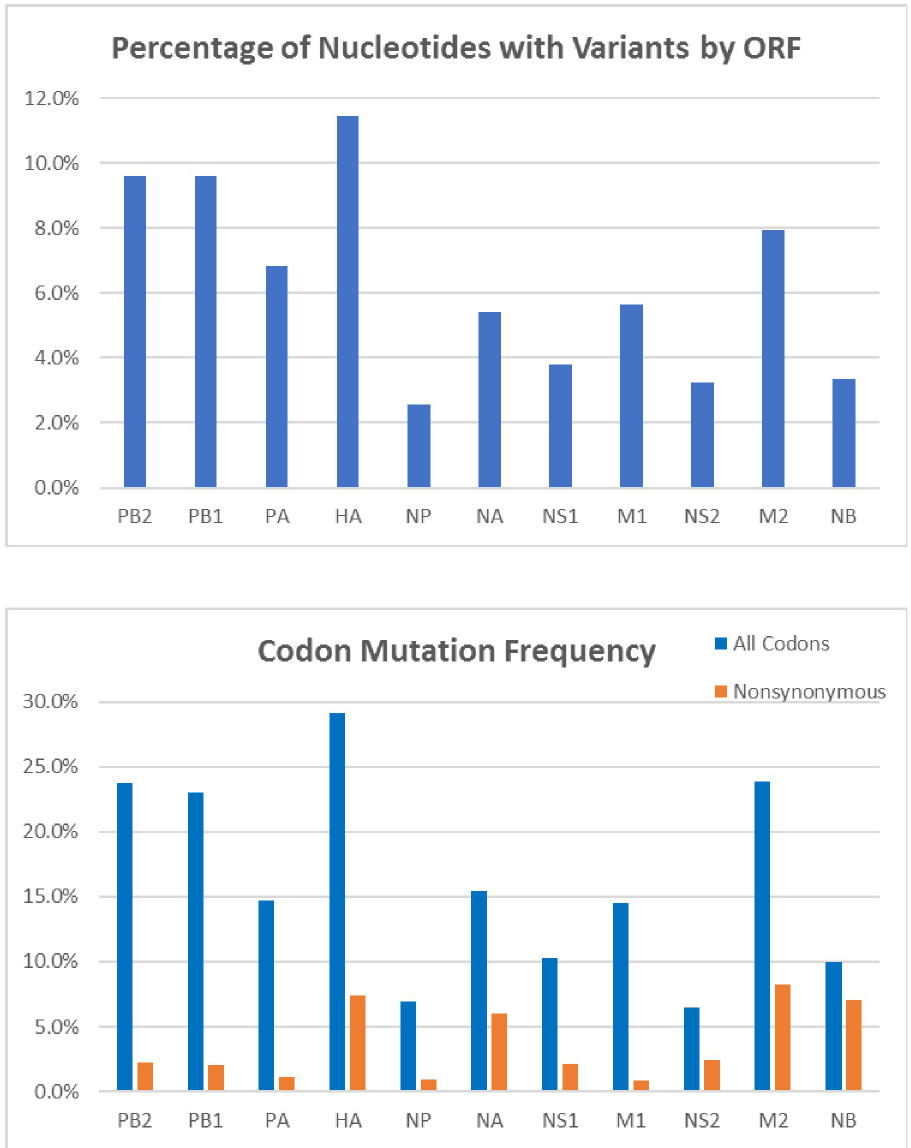
Fig 3. Frequency of variants among ORFs and codons. A; The percentage of nucleotides containing variants at levels greater than 5% is graphed for each ORF. B; The percentage of codons containing variants is graphed for each ORF. The percentage of codons with variants that result in nonsynonymous changes is